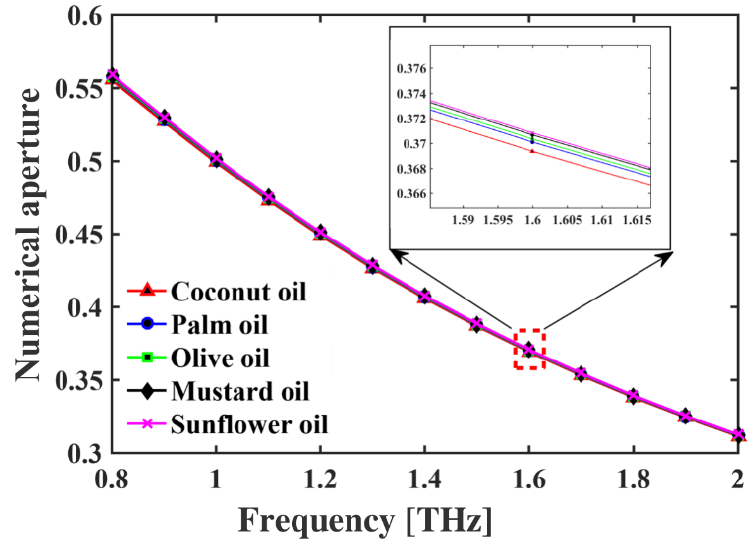
Figure 7. The numerical aperture of the proposed oil detector for different operating frequencies.